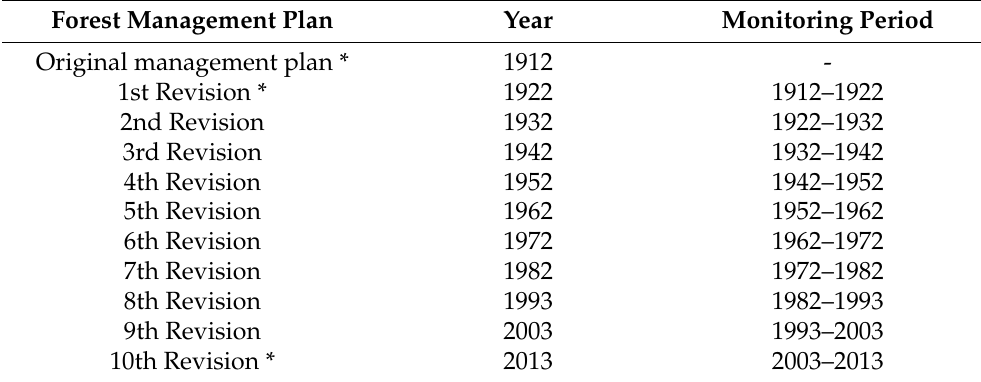
Table 1. Year of implementation and monitoring period of the management plan and its